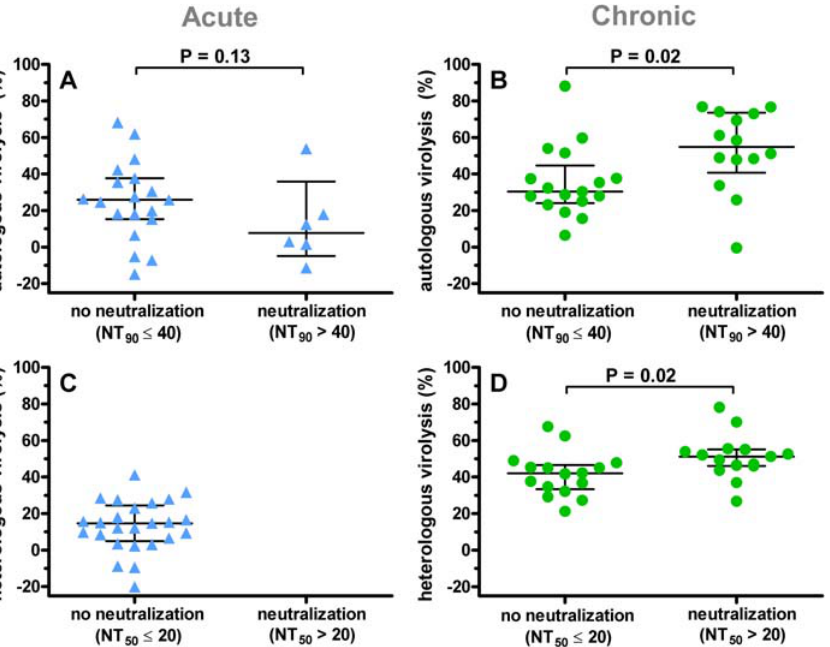
Figure 6. Neutralizing Antibodies Are Not the Major Constituent of Complement Lysis-Inducing Antibodies Complement lysis activity of non-neutralizing and neutralizing patient plasmas was compared in the acute and the chronic infection cohorts. Autologous neutralization (A and B) and heterologous (JR-FL) (C and D) neutralization are shown, with blue triangles denoting acutely, green circles chronically infected patients. Each data point represents the mean of two or three independent experiments with plasma from the same patient. Groups were compared using Mann-Whitney U test.